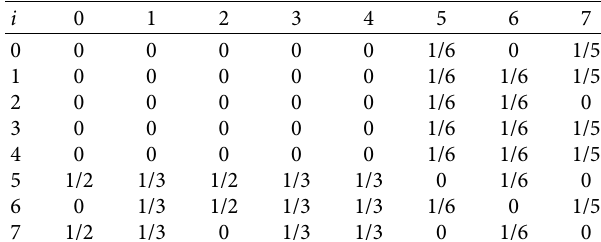
Table 4: The normalized adjacency matrix based on each